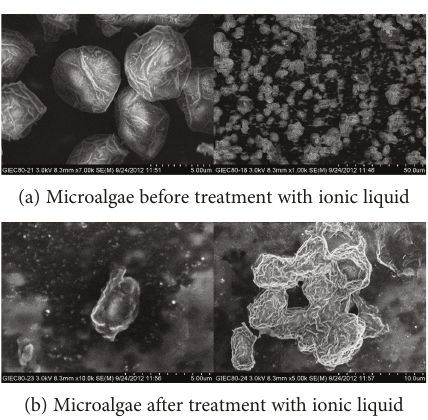
(b) Microalgae after treatment with ionic liquid Figure 2: The in fl uence of types of ionic liquids on lipid extraction.